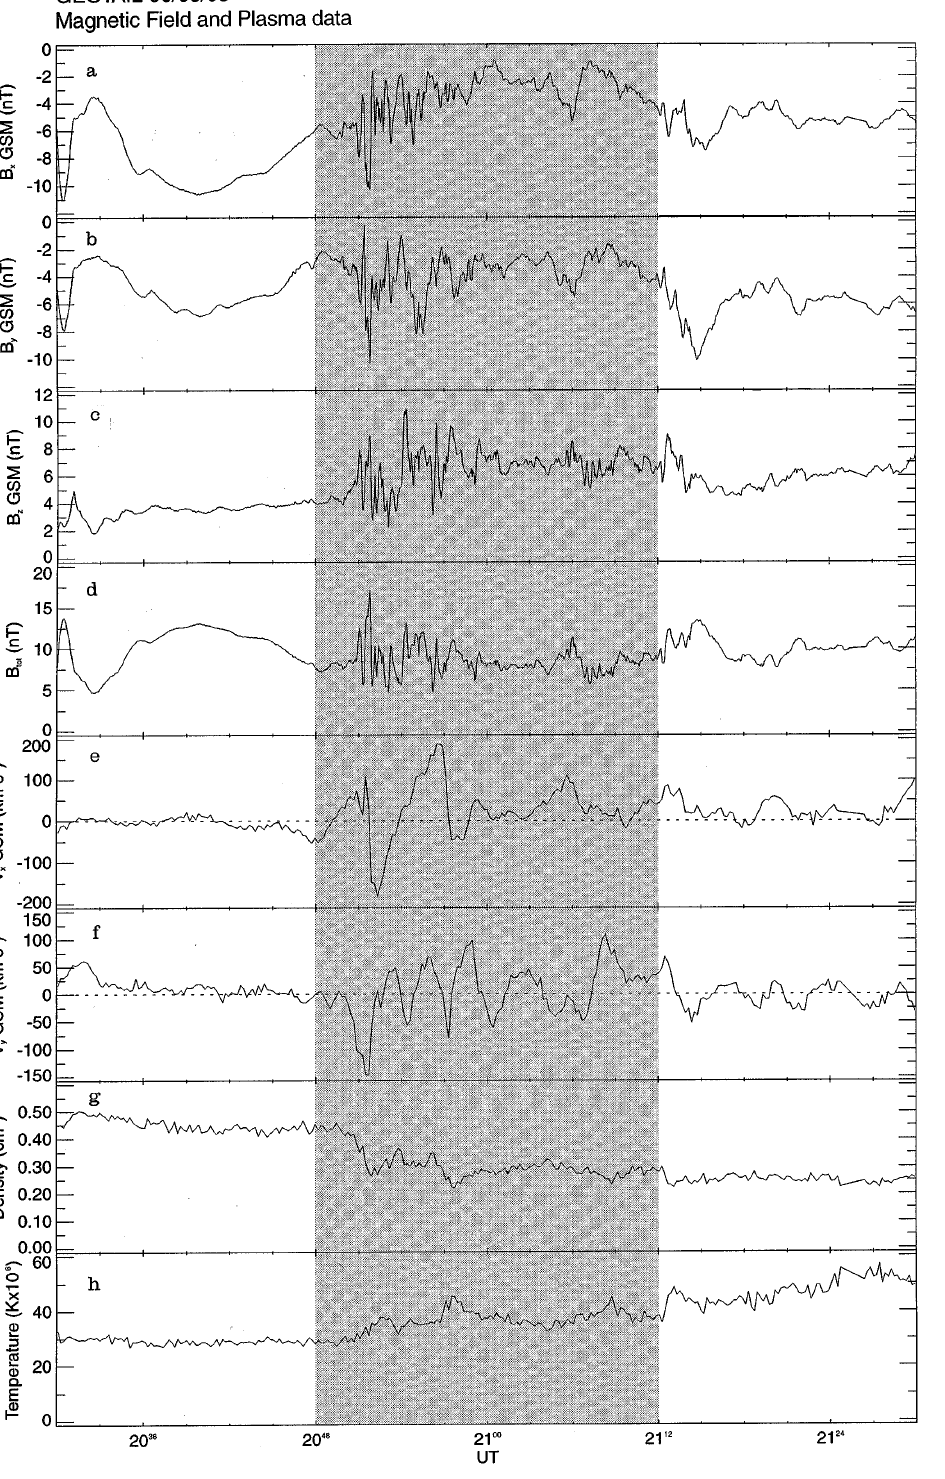
beam has a sampling rate of 14 s and points in a meridional direction, and range gate 25 is that which overlies the ground magnetometer station at BJN. The